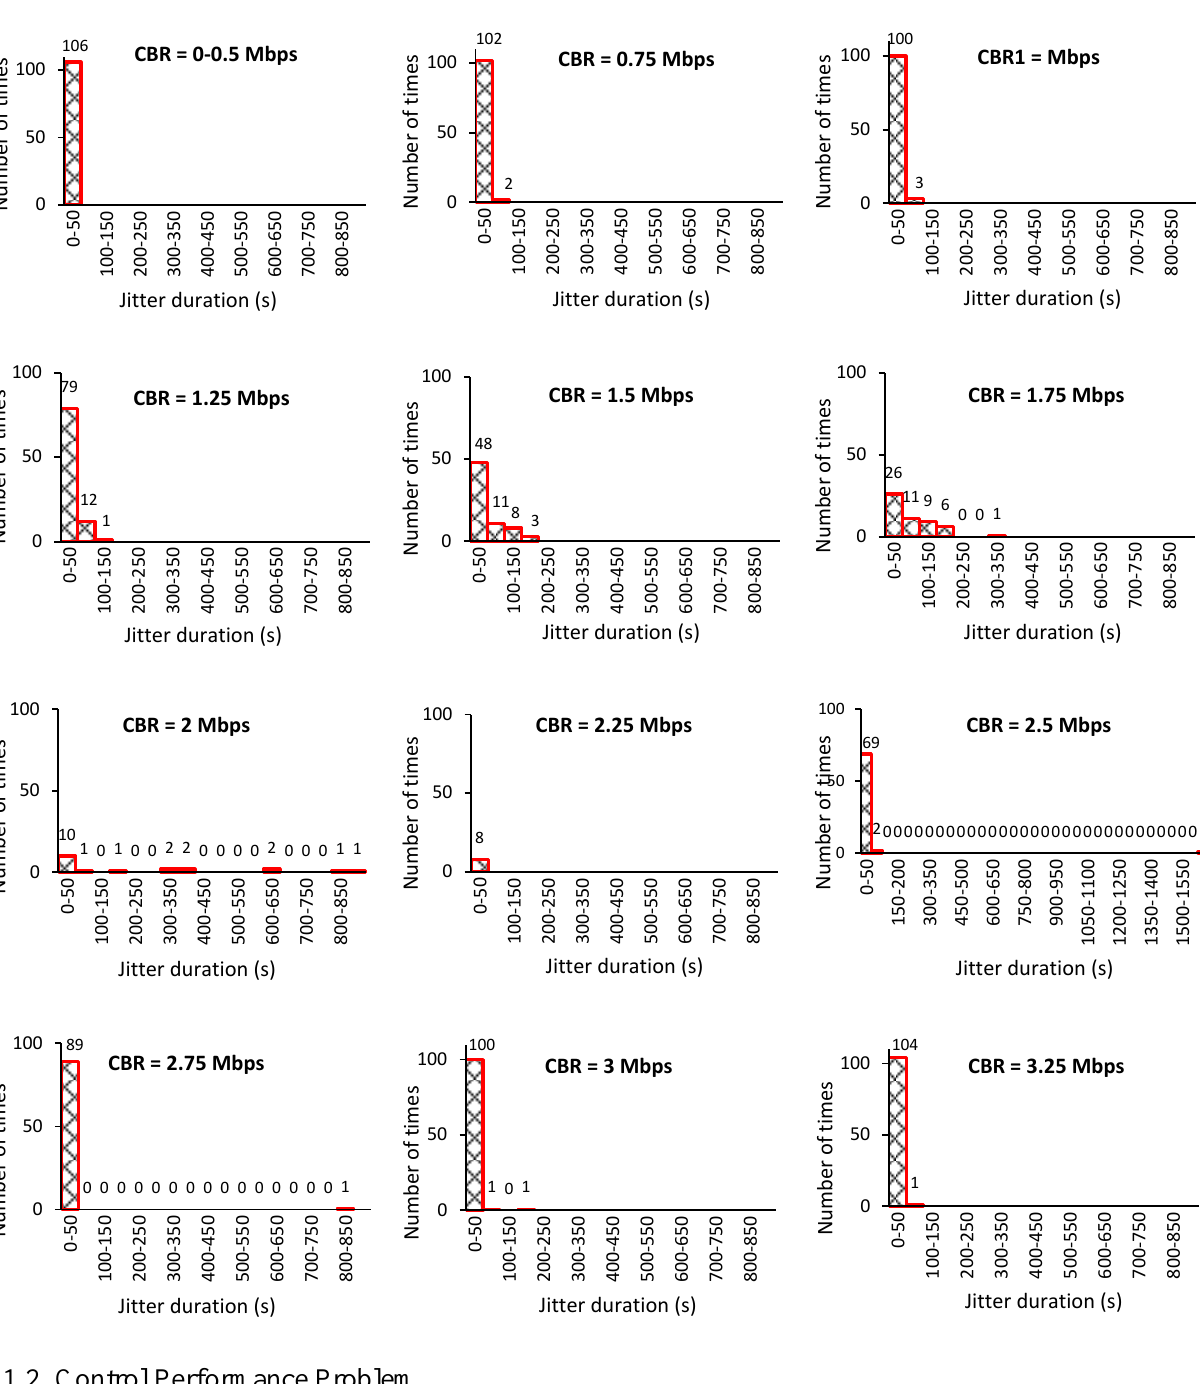
Figure 3. Jitter duration